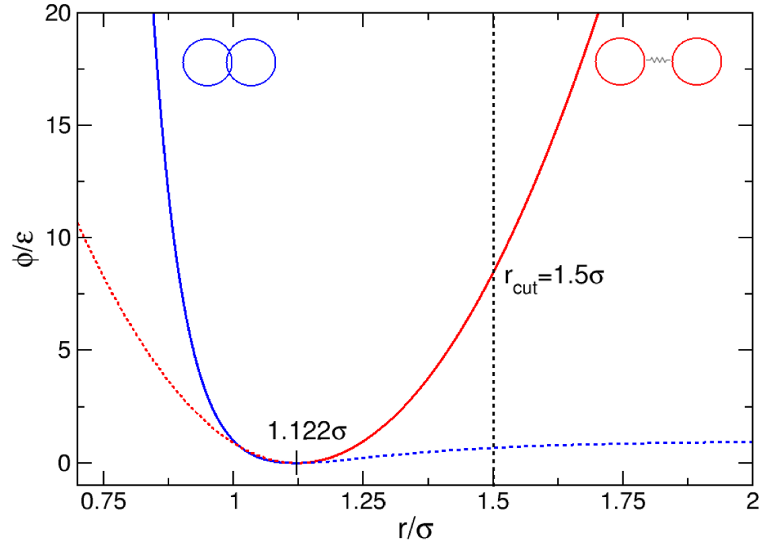
Figure 3. Repulsive and cohesive potentials used in the model. The solid blue line (left side) represents the Lennard-Jones potential and the solid red line (right side) represents the spring potential. The combined blue and red solid lines govern the forces acting on each particle pair; the dotted lines are